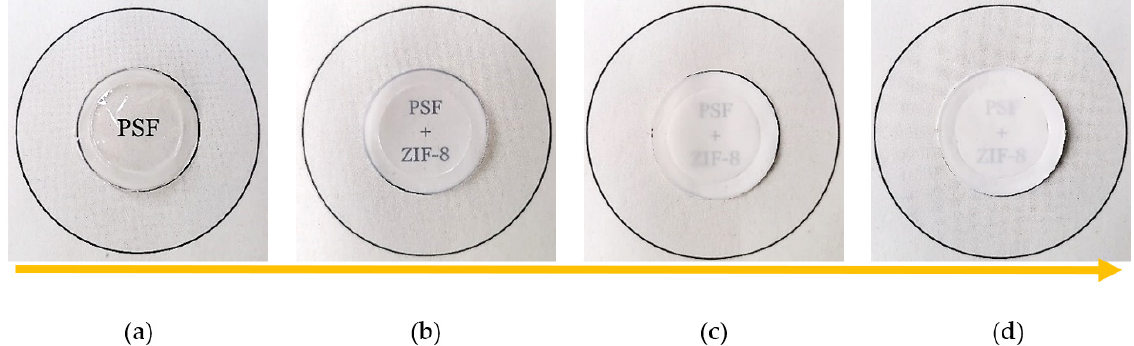
Figure 2. Membrane samples used for permeation tests: ( a ) PSf; ( b ) PSf/2% ZIF-8; ( c ) PSf/8% ZIF-8; ( d ) PSf/16% ZIF-8. The arrow indicates increasing filler content.